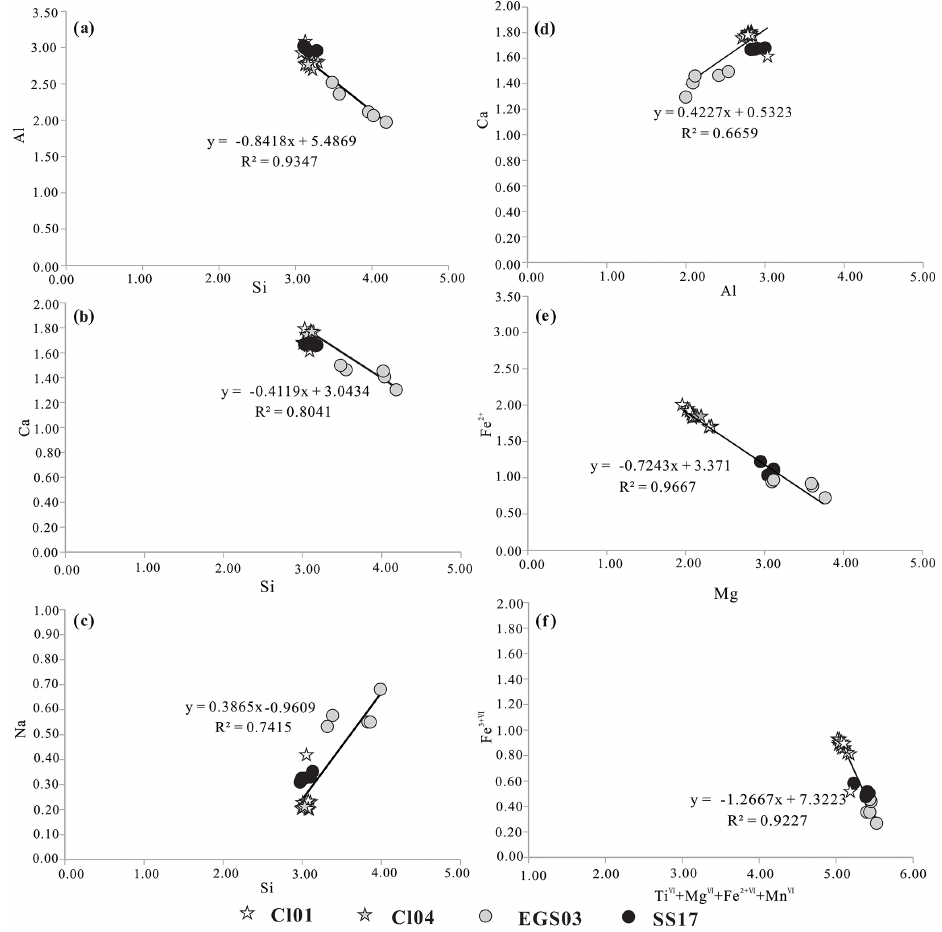
Figure 6. Correlation diagrams of selected major elements in Changle rhönite. Values along axes are given in atoms per formula